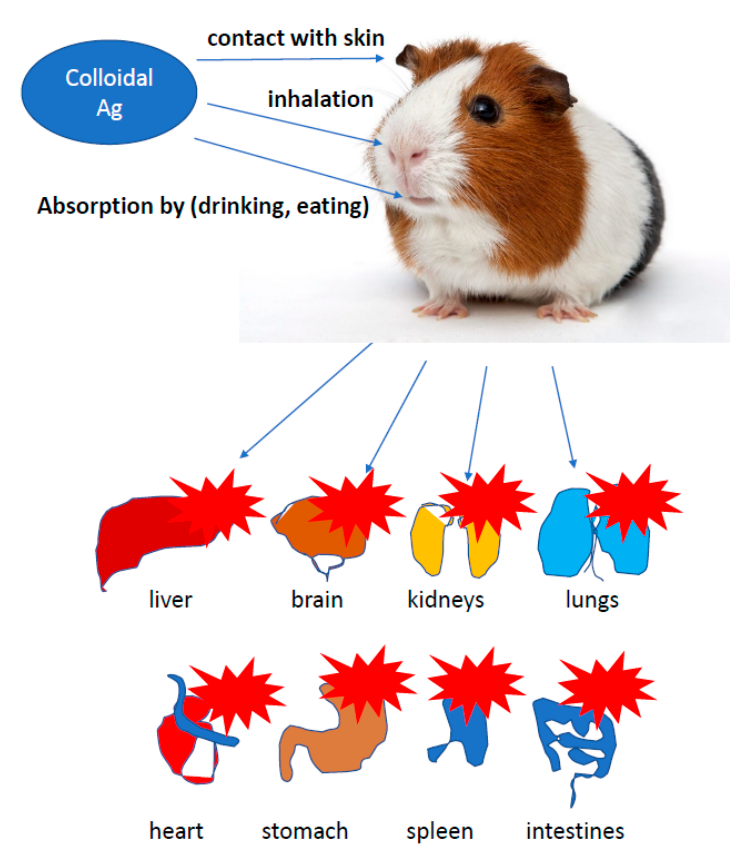
Figure 7. Negative role of colloidal silver. Colloidal silver can accumulate in different tissues of rodents like kidneys, liver, intestines, tongue and brain. They cause cell death, through DNA damage. Nanoparticles of various metals, such as silver, gold, copper, titanium oxides, zinc and iron, can enter the body in three different ways: by inhalation, by ingestion while eating or drinking and through the skin. The most popular NPs metal is titanium diox- ide [29,121,123,125]. As opposed to silver ions, its nanoparticles show a strong tendency to aggregation, which makes them lose their positive properties. On the other hand, silver ions, due to the presence of charge, have a high affinity to functional groups that are also part of human cells [29,93]. Therefore, work is still ongoing to create particles with strong antibacterial properties that are safe for eukaryotic cells. These particles would not aggregate, leading to a loss of physicochemical properties and, consequently, a reduc- tion of biological activity [143–151]. The way to solve this problem and maintain